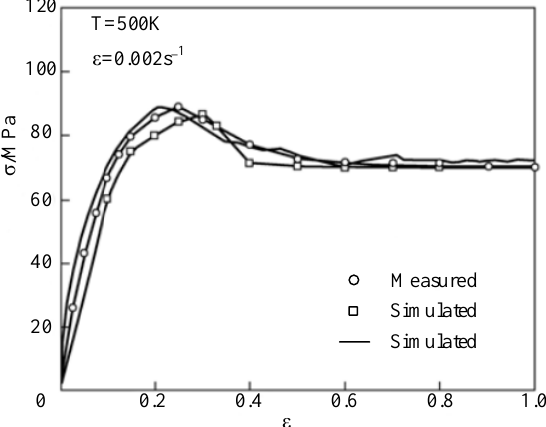
Figure 21. Comparison of simulated strain curves of OFHC copper [47].